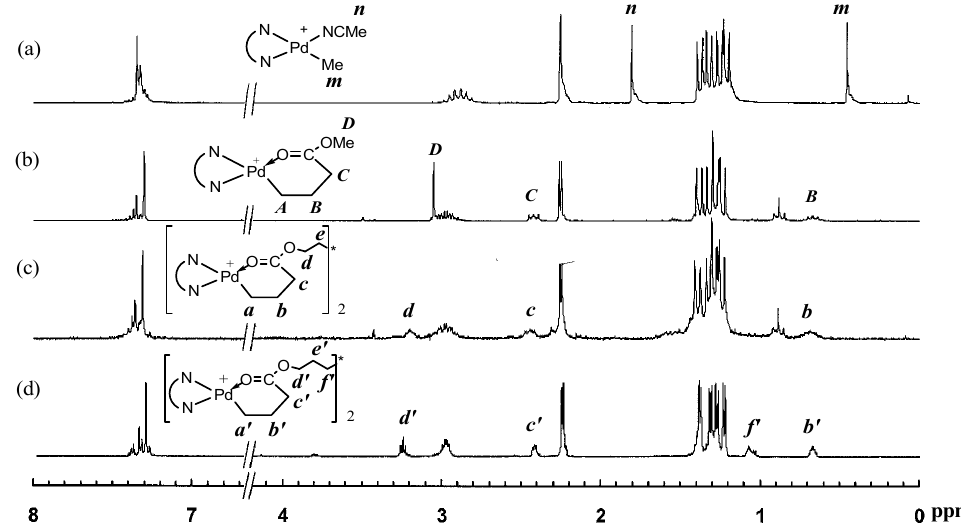
Figure 1. 1 H NMR spectra for the Pd–diimine compounds: ( a ) 1 ; ( b ) 2 ; ( c ) 3a ; and ( d ) 3b . The resonance peaks from the diamine ligand are not labeled. Peaks for A , a , e , a’ , and e’ overlap with the peaks for methyl protons (1.2–1.45 ppm) on the isopropyl groups of the diimine ligand.